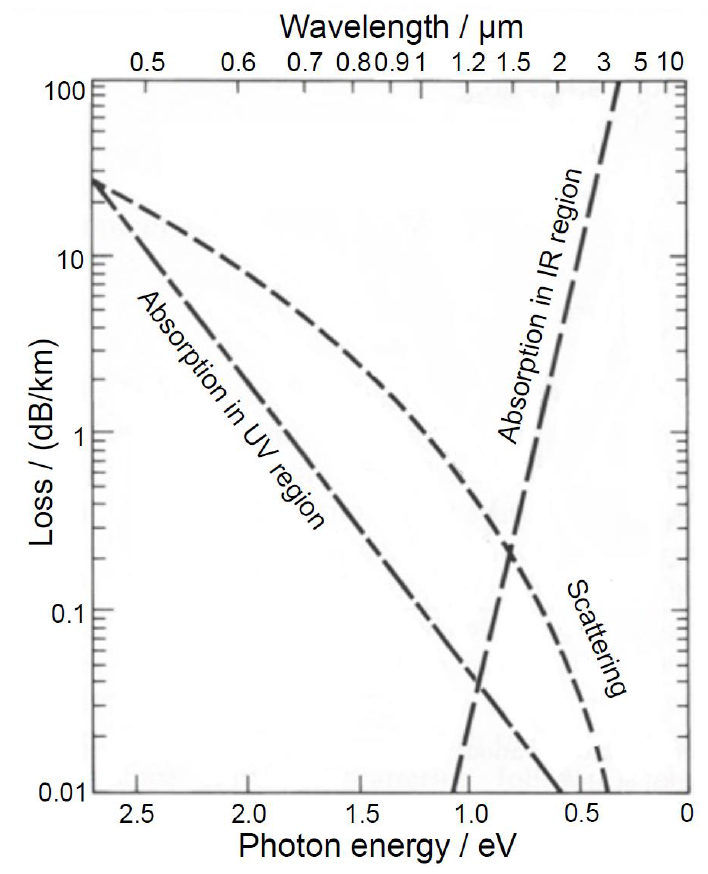
Figure 8. Diagram of the wavelength-dependent loss mechanisms of absorption and scattering (adapted from Horiguchi and Osanai [31] with permission from the Institution of Engineering and Technology (IET) 2023), presented here in units of dB/km. Regarding the studies here, the loss mechanisms are reflected in the changes in power, intensity, and line widths